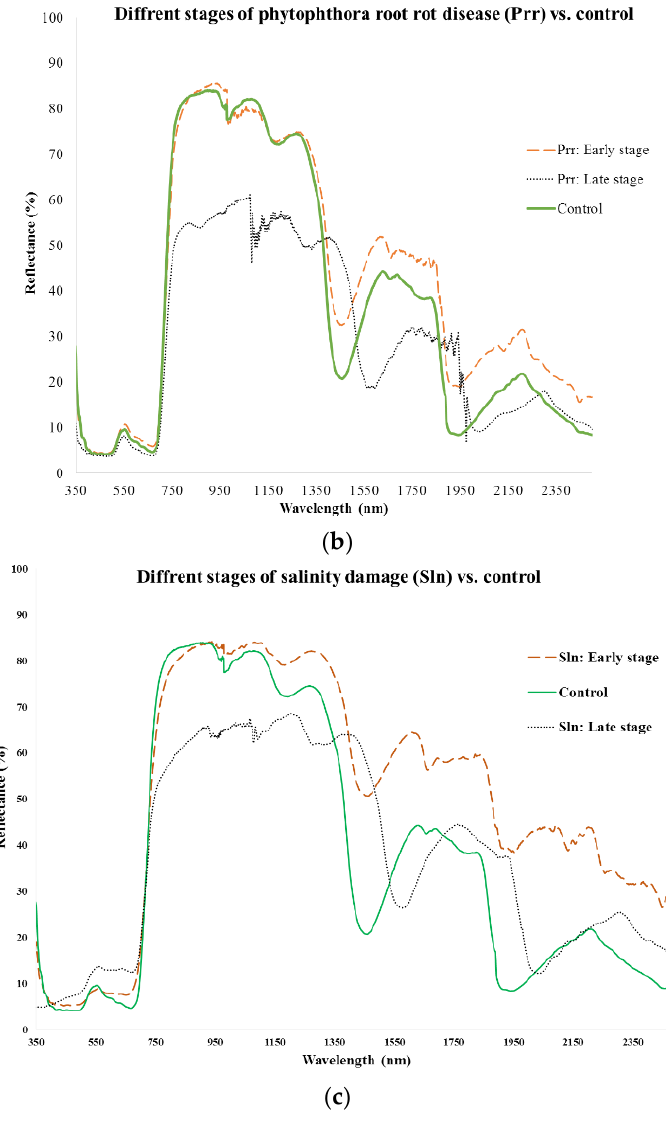
Figure 3. Spectral signature for laurel wilt disease ( a ); Phytophthora root rot ( b ); and salinity damage ( c ) in early and advanced stages vs. control.